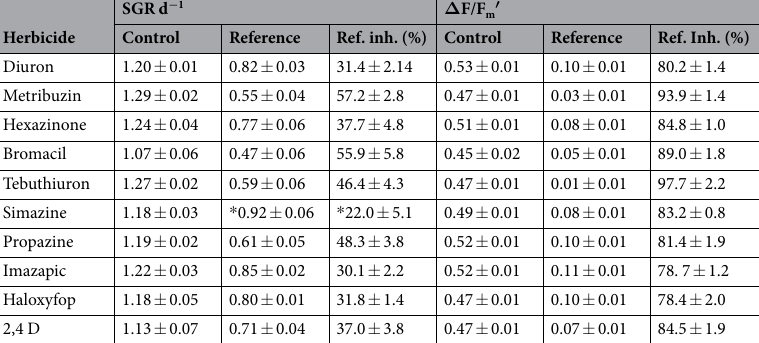
Table 2. Assay performance. Specific growth rate (SGR, d − 1 ) and photosynthetic efficiency ( Δ F/F m ′ ) measurements of control and reference (diuron, 4 µ g L − 1 ) treatments and diuron reference percent inhibition effect (Ref. inh (%)) (mean ± SD; n = 5 per treatment). * Note for the simazine toxicity bioassay, a reference treatment of diuron, 2 µ g L − 1 was used instead of 4 µ g L − 1 and therefore not included in calculations of the total